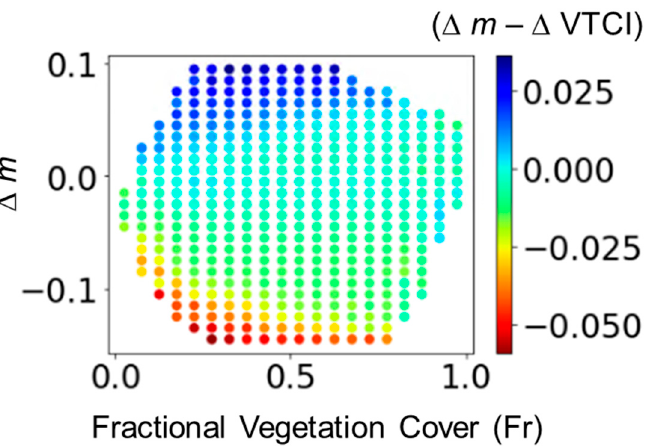
Figure 10. Fuel moisture difference between FFMC and VTCI in ∆ m—fractional vegetation cover data space.